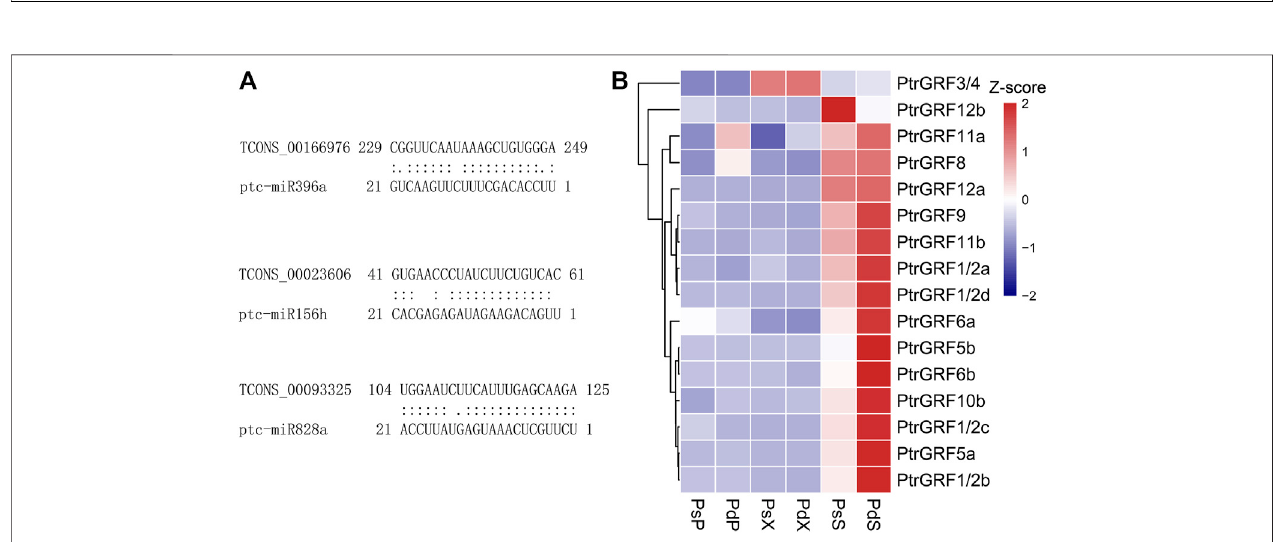
FIGURE7| ExpressionanalysisofrelatedlncRNAsaspotentialtargetsortargetmimicsofmiRNAs. (A) PredictedbindingalignmentoflncRNAswithptc-miR396a, ptc-miR156h, and ptc-miR828a. (B) Expression patterns of differentially expressed GRFs and the target genes of miR396 in the two species.